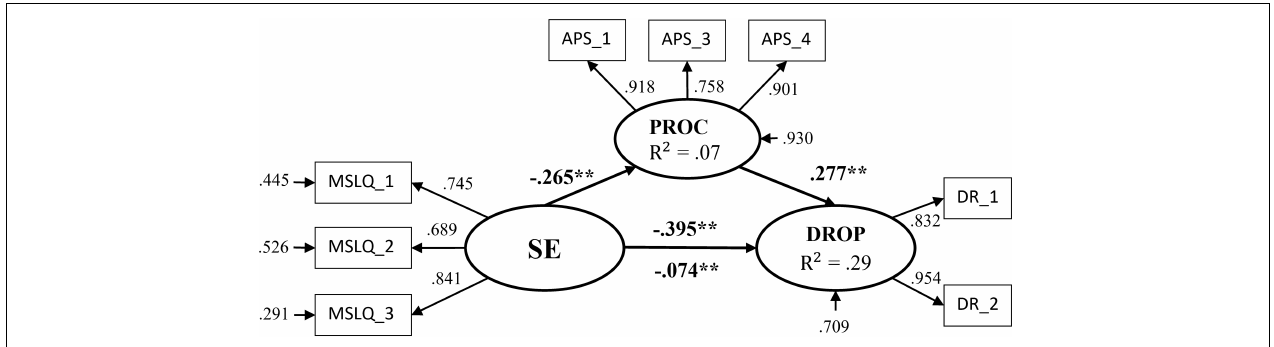
FIGURE 1 | Mediation model for drop-out intentions ( n = 693). Indirect effect is provided below the path line. SE, academic self-efficacy; PROC, procrastination; DROP, drop-out intentions. ** p ≤ 0.001.